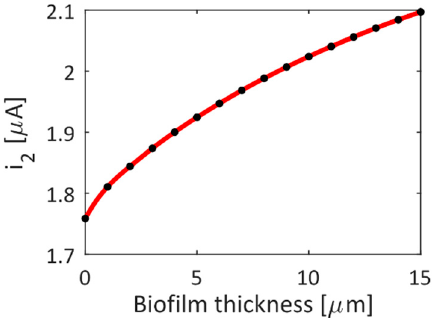
Figure 7. Current i 2 [µA] in the IME structure with N = 100, f 2 = 1 kHz, and G = W = 50 µm for different values of biofilm thickness. Plots calculated by 2D FEM approach.